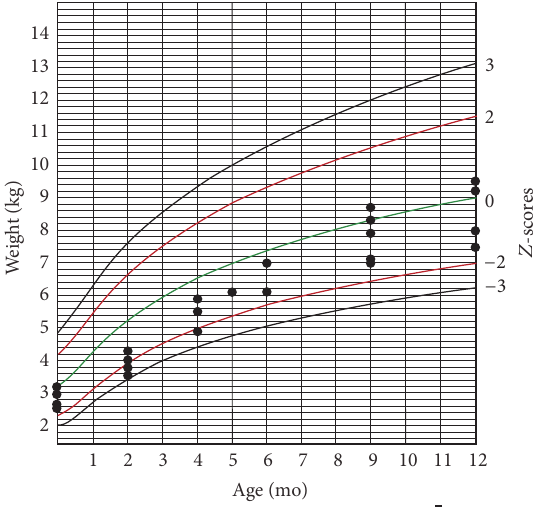
Figure 2: Weight-for-age chart for girls during one-year follow-up.